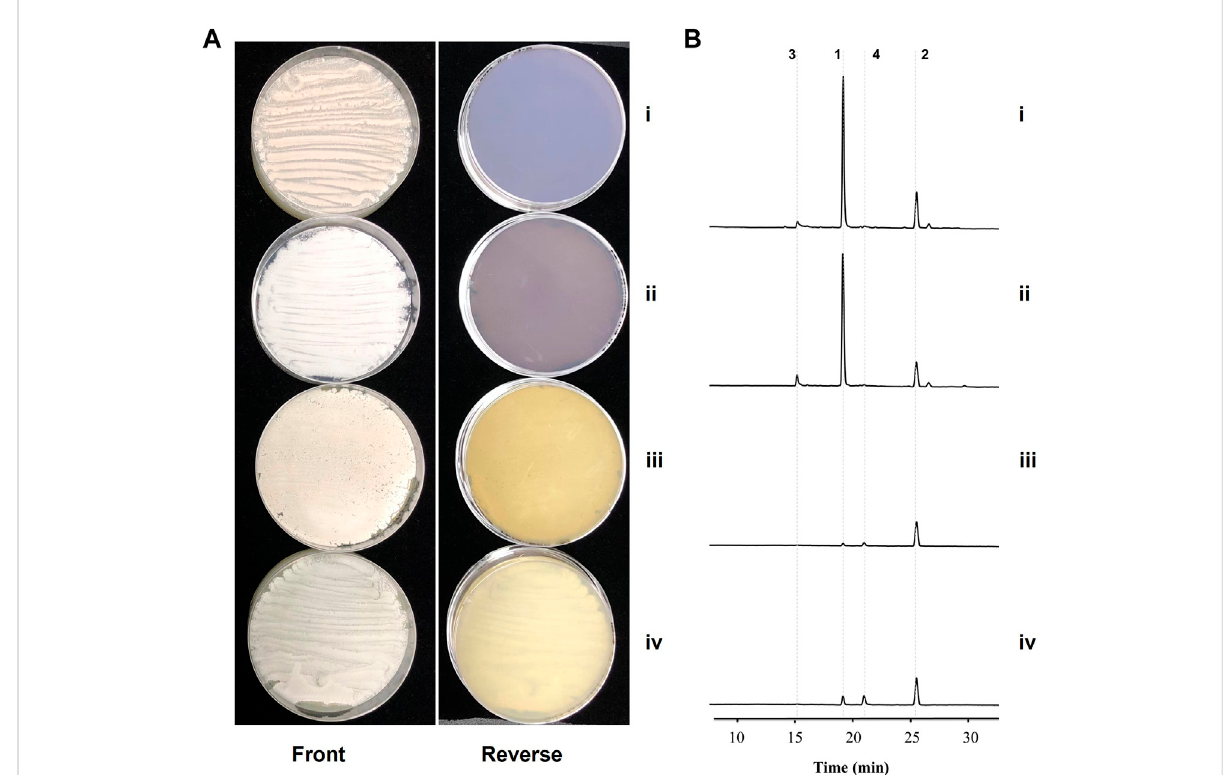
FIGURE 4 Inactivations of the spore pigment and the kinamycin-like pathways in the gra-orf32 deletion background. i, the parent mutant Δ gra-orf32 ; ii, the double deletion mutant Δ gra-orf32 Δ pig-pks ; iii, the double deletion mutant Δ gra-orf32 Δ kina-like-pks ; iv, the triple deletion mutant Δ gra- orf32 Δ kina-like-pks Δ pig-pks . (A) CulturesofmutantonISP2platesat7 d (B) HPLCmetabolic pro fi lingofthemutants.TheUVabsorbancedatawere collected at the wavelength of 520 nm. 1 , granaticin; 2 , granaticin B; 3 , granaticinic acid; 4 , granaticinic acid